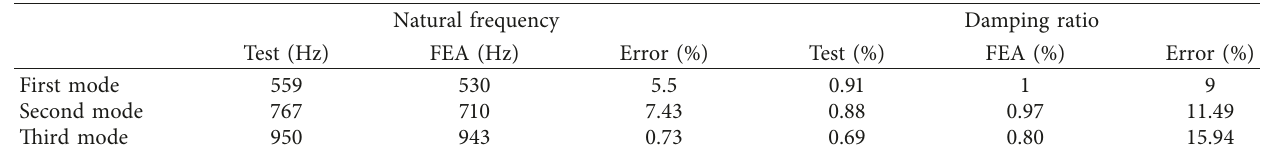
Figure 8: Frequency and damping ratio of the CFRP motor frame. (a) Second-Mode Modal. (b) Third-Mode Modal. Table 4: Modal Experimental results of the CFRP motor frame.